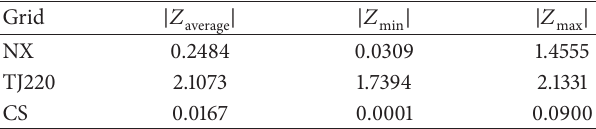
Table 3: Electrical distance between